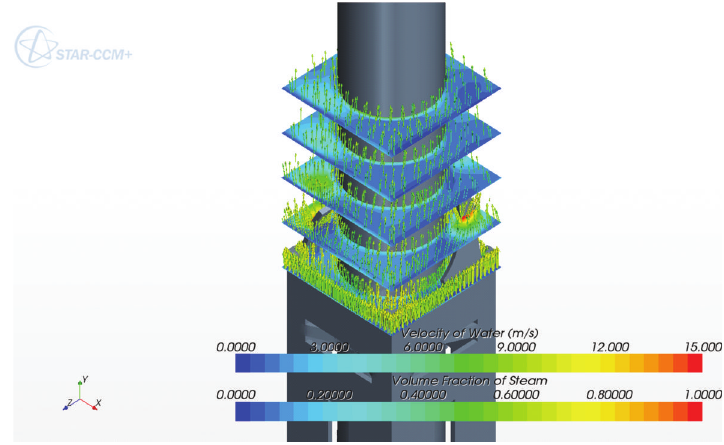
Figure 11: Velocity distribution above mixing vane spacer around one